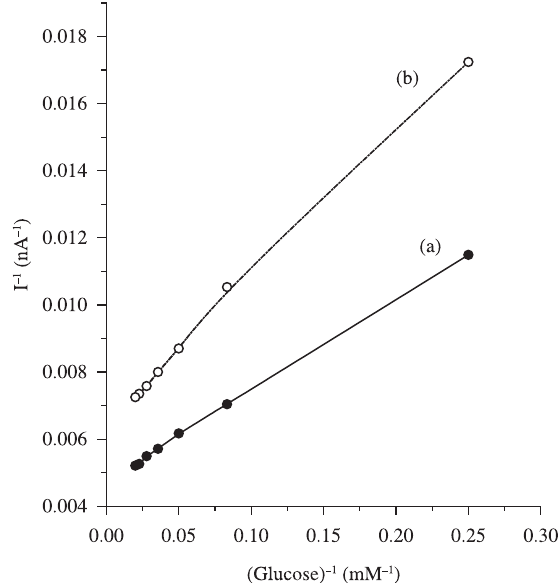
Figure 6. Electrochemical Lineweaver-Burk plot for PGLD (a) and CHD (b) biosensors based on the data of Figure 5.